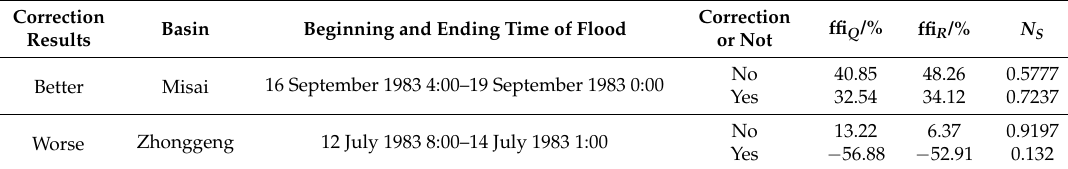
Table 16. Statistics of typical over-estimated floods.